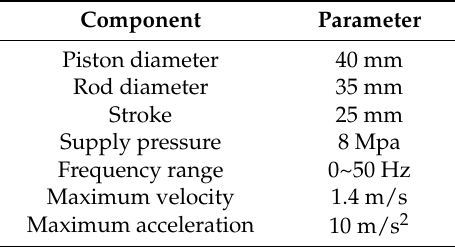
Table 1. The main parameters of shaking table.